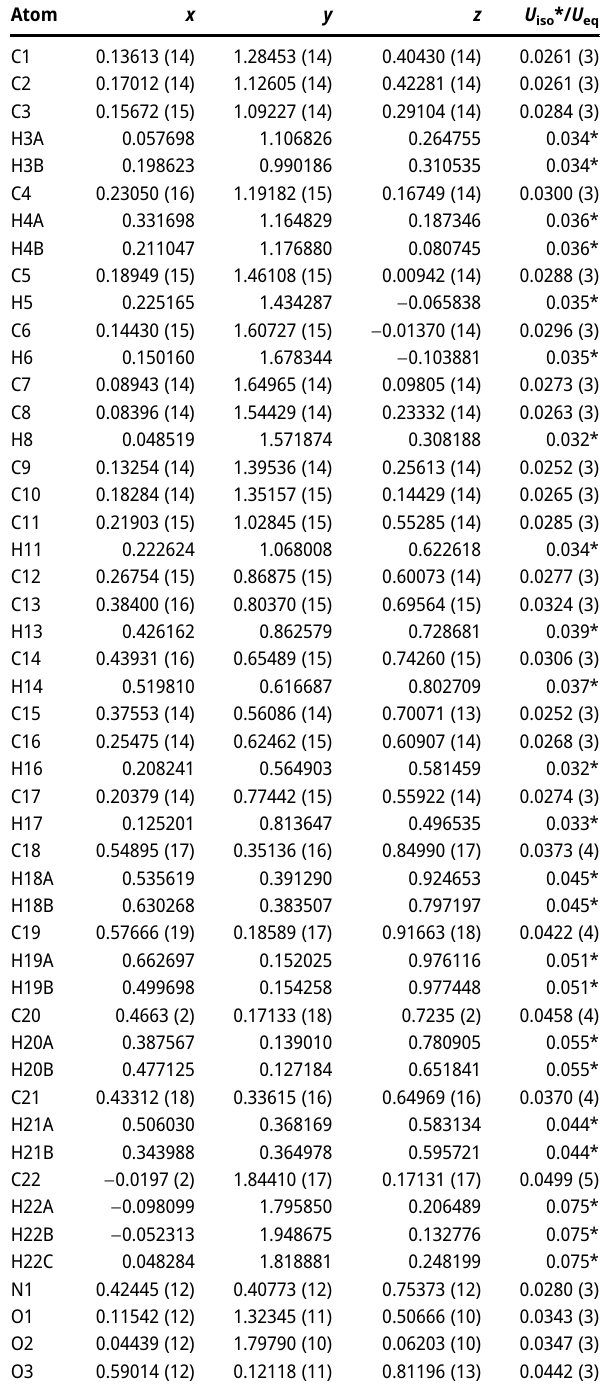
Table  : Fractional atomic coordinates and isotropic or equivalent isotropic displacement parameters (Å 